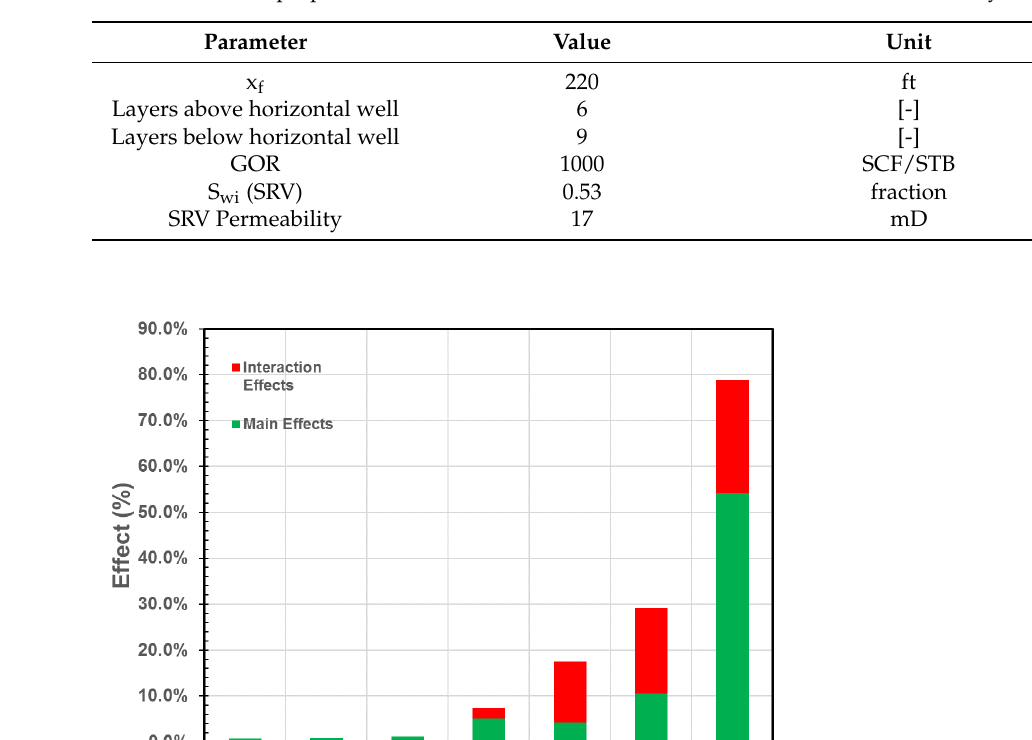
Table 3. Reservoir properties derived from the best-case simulation numerical model history match.